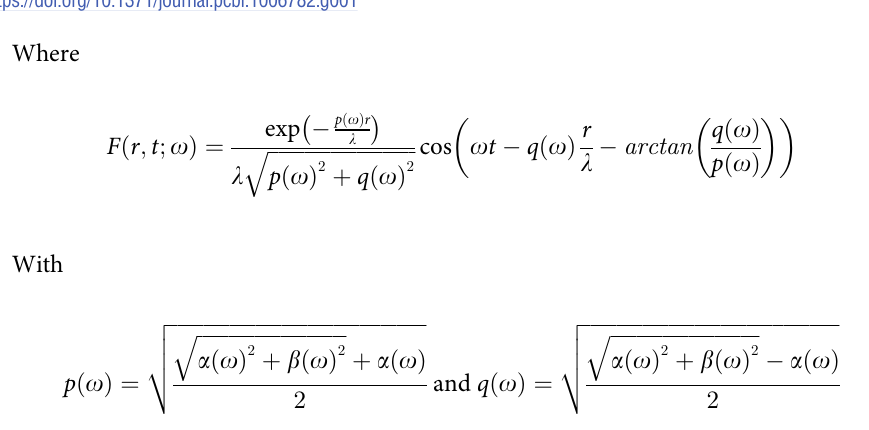
Fig 1. A cable theoretic model of optogenetic dendritic activation. A: Our model of the dendrite consists of a semi- infinite linear cable, where the somatic boundary at x = 0 is kept at a constant holding potential u(0 , t) = u Optogenetic stimulation is modeled as a band of illumination starting at the soma and ending at R (green). Alternatively, x = R can be the locus of a point illumination (purple line indicates afferent axon terminating at the point). Stimulus is a temporal sine waveform (green) and the somatic current response is an attenuated and phase shifted version of it (black). The phase shift of the somatic current injection is F R for point illumination and F 0 for band illumination starting at x = 0 and ending at x = R . B: The phase shift between a sinusoidal optogenetic stimulation and the corresponding somatic current response as a function of the ratio between R and the dendrite’s electrotonic distance λ for band (green) and point stimulation (purple). The phase shift for band stimulation is bounded (red), while point stimulation is not bounded. Both curves are calculated for f = 10 Hz and τ = 10 ms.